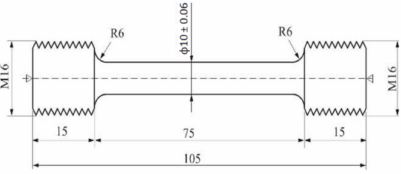
Figure 4. Shape and size of samples for static tensile test.